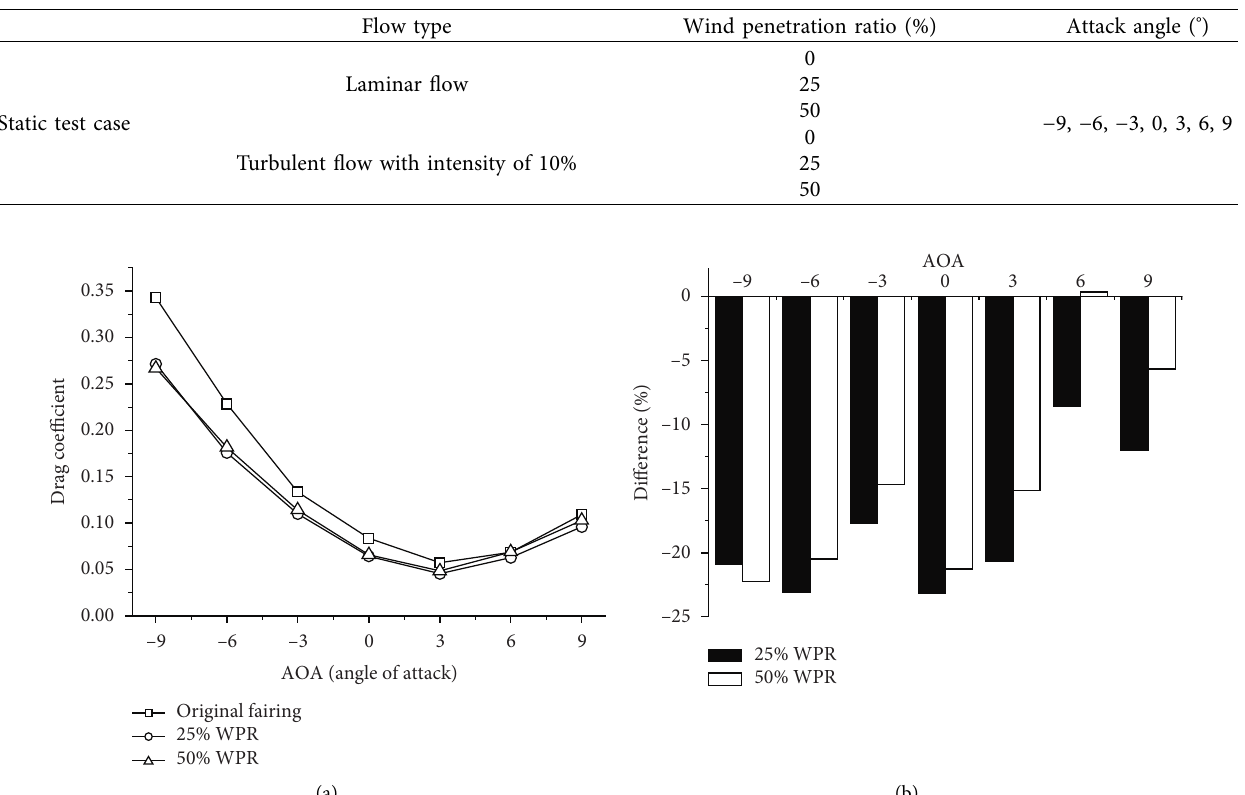
Table 2: Static wind tunnel test cases.